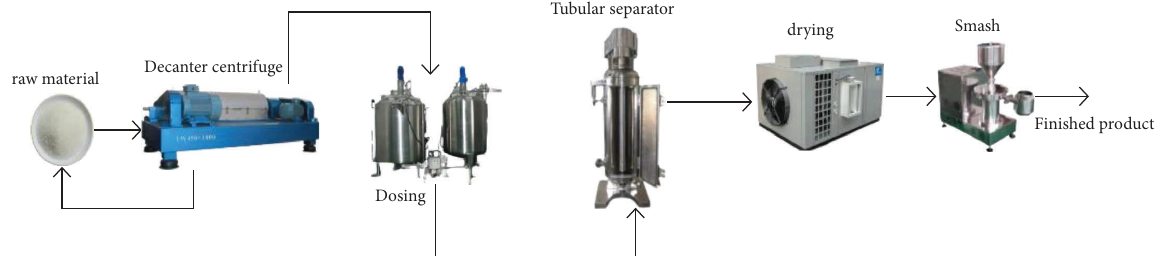
Figure 1: Physical picture of the preparation process of nanomaterials.